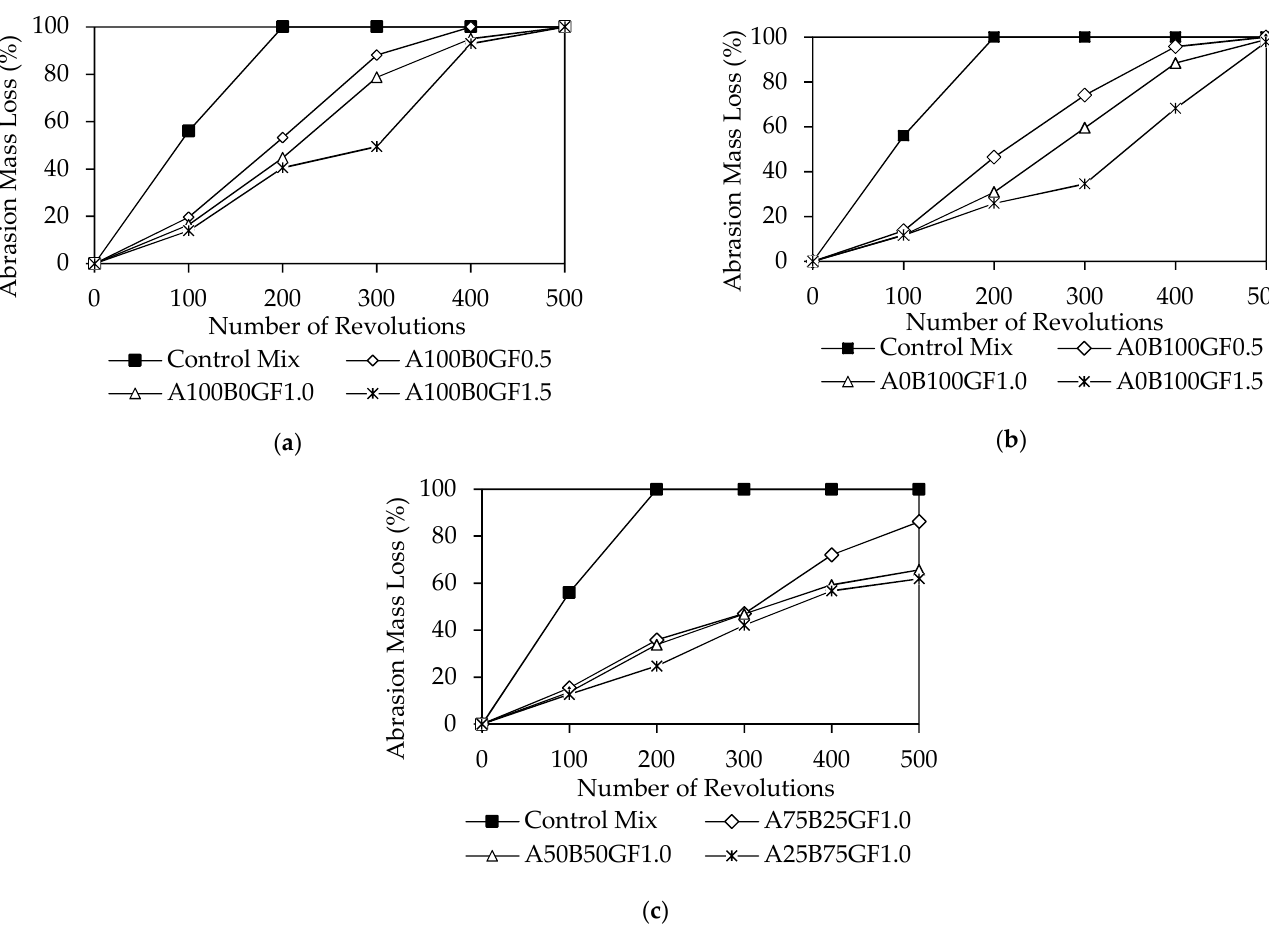
Figure 14. Abrasion resistance of: ( a ) Series A, ( b ) Series B, and ( c ) Series C mixes.